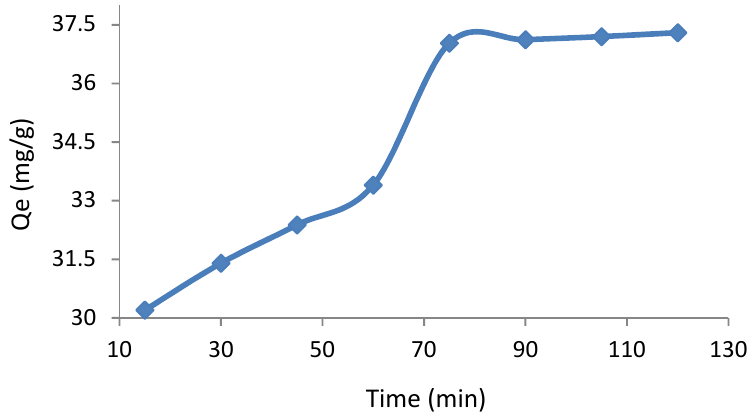
3031.53334.53637.5